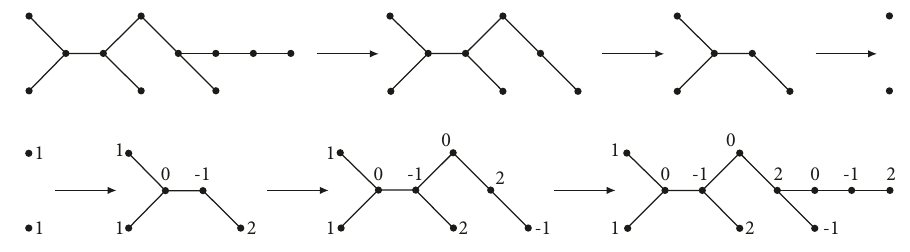
Figure 7: Reduction to get the solution.